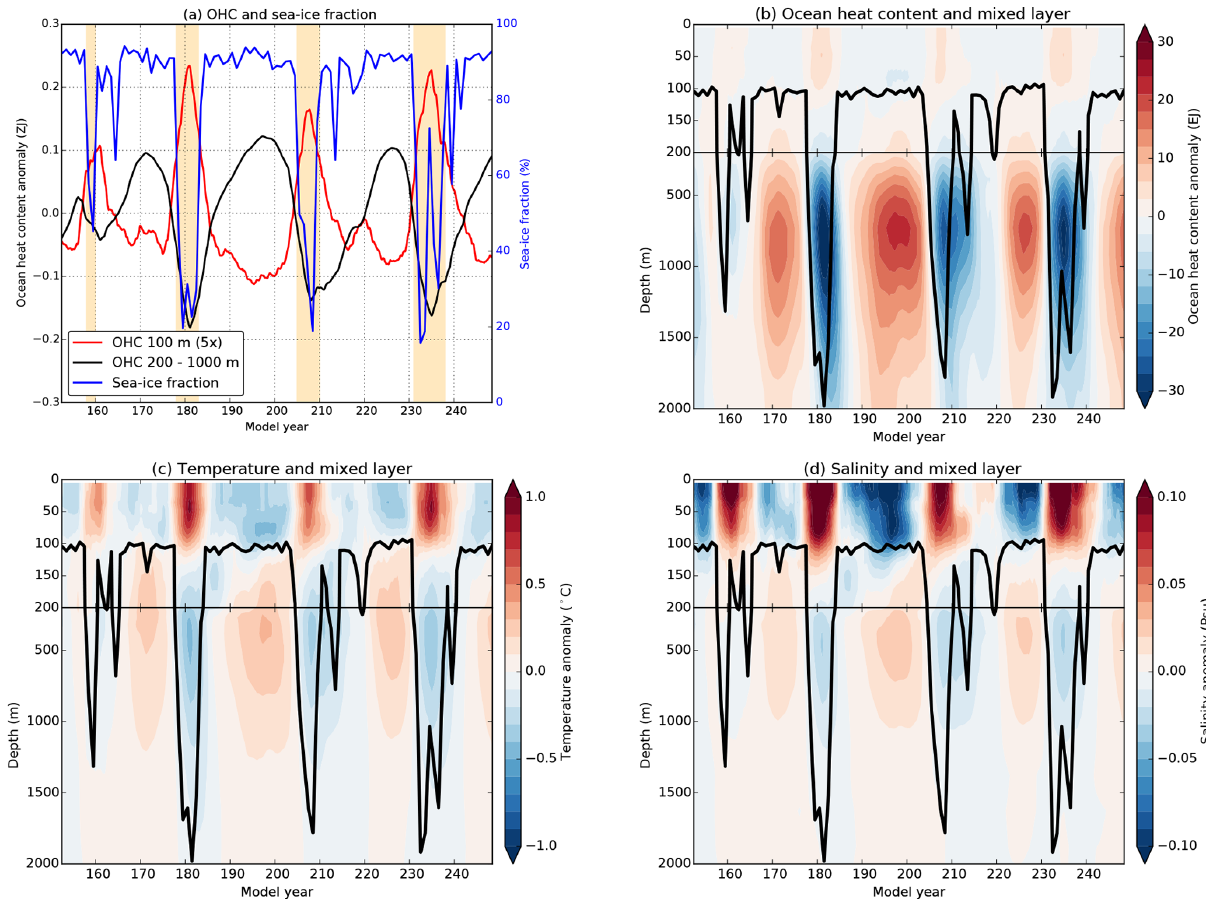
Figure 4. (a) Time series of the upper 100m OHC anomaly ( H 100 , magnified by a factor of 5), the 200–1000m OHC anomaly ( H 1000 ) and the September sea-ice fraction averaged over the polynya region. The OHC time series are quadratically detrended and smoothed by a 60-month running mean. The shading indicates the polynya years. (b) Hovmöller diagram of the OHC anomaly vertical distribution (anomaly of OHC with respect to the time mean) over the polynya region, smoothed by a 60-month running mean. The black curve indicates the annual maximum mixed layer depth. (c, d) Same as panel (b) but now for the oceanic (c) temperature and (d)